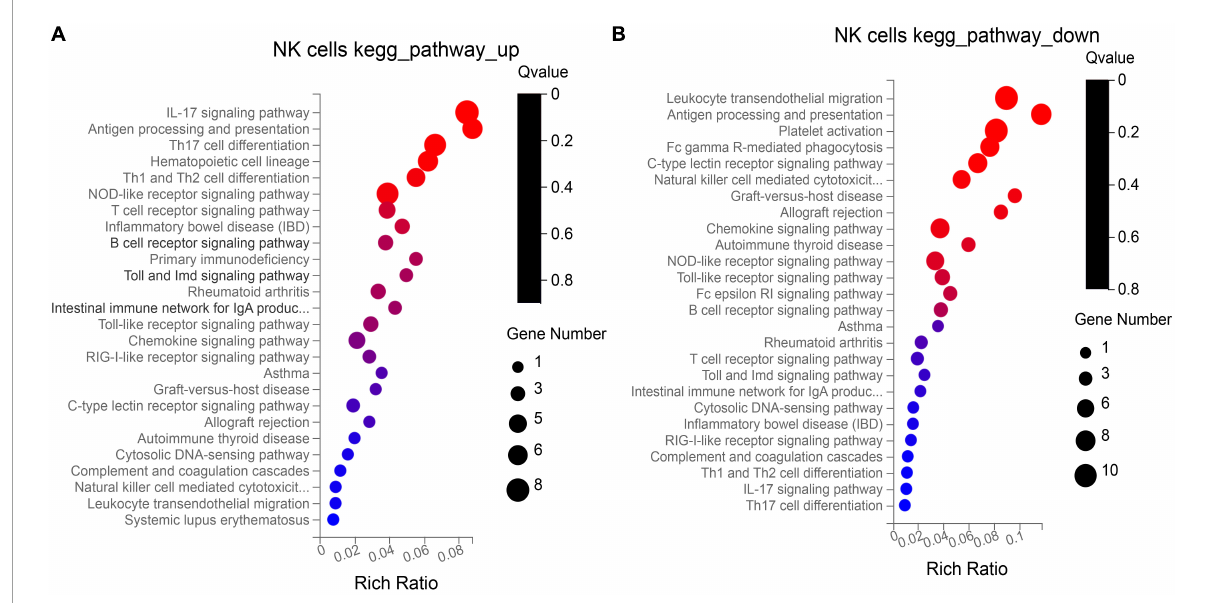
FIGURE3 Kyoto encyclopedia of genes and genomes (KEGG) enrichment analysis of up-regulation (A) and down-regulation (B) genes in NK cells.